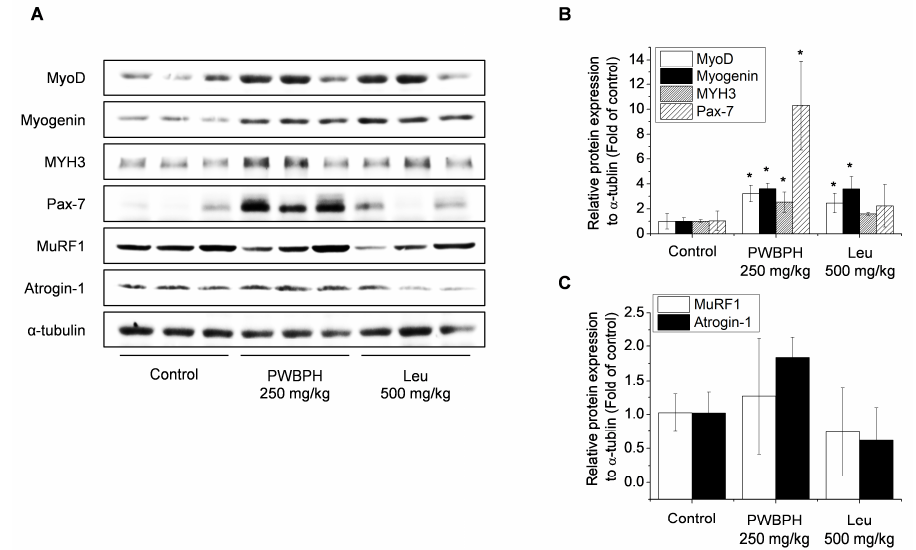
Figure 2. Effects of PWBPH supplementation on skeletal muscle differentiation in vivo. ( A ) The levels of muscle differentiation proteins (MyoD, myogenin, MYH3, and Pax7) and muscle degradation proteins (MuRF1 and atrogin-1) in the Gas muscle of the control, PWBPH 250 mg/kg, and Leu 500 mg/kg groups were determined by Western blotting. ( B , C ) The band intensities were measured using Image J software. Data are shown as the means ± SD ( n = 3). * p < 0.05 vs. control group.